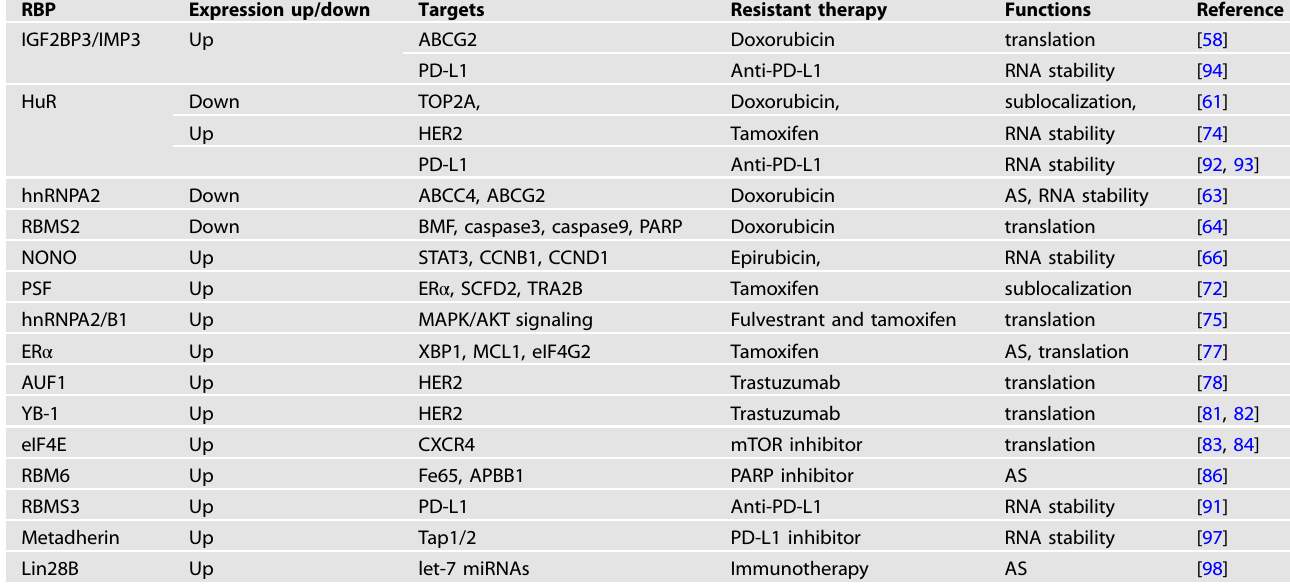
Table 2. Altered RBPs in treatment resistance of breast